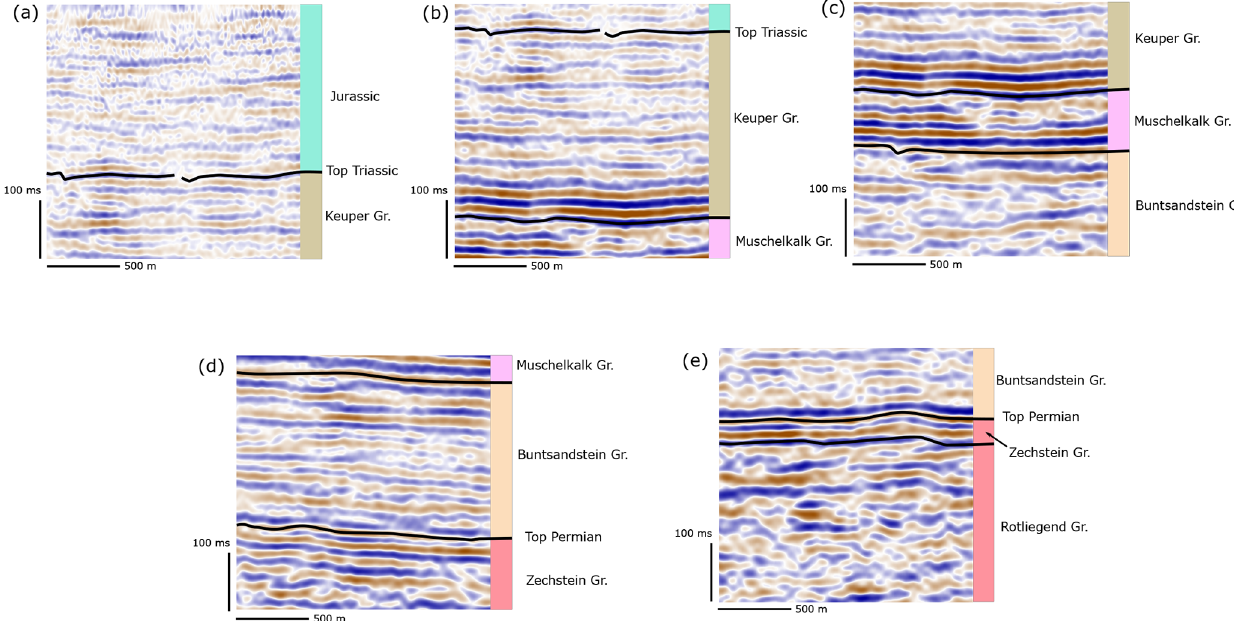
Figure 3. Seismo-stratigraphic facies of observed Permian–Jurassic stratigraphy in the study area: (a) Jurassic, (b) Upper Triassic Keuper Group, (c) Middle Triassic Muschelkalk Group, (d) Lower Triassic Buntsandstein Group, and (d) Permian Zechstein and Rotliegend